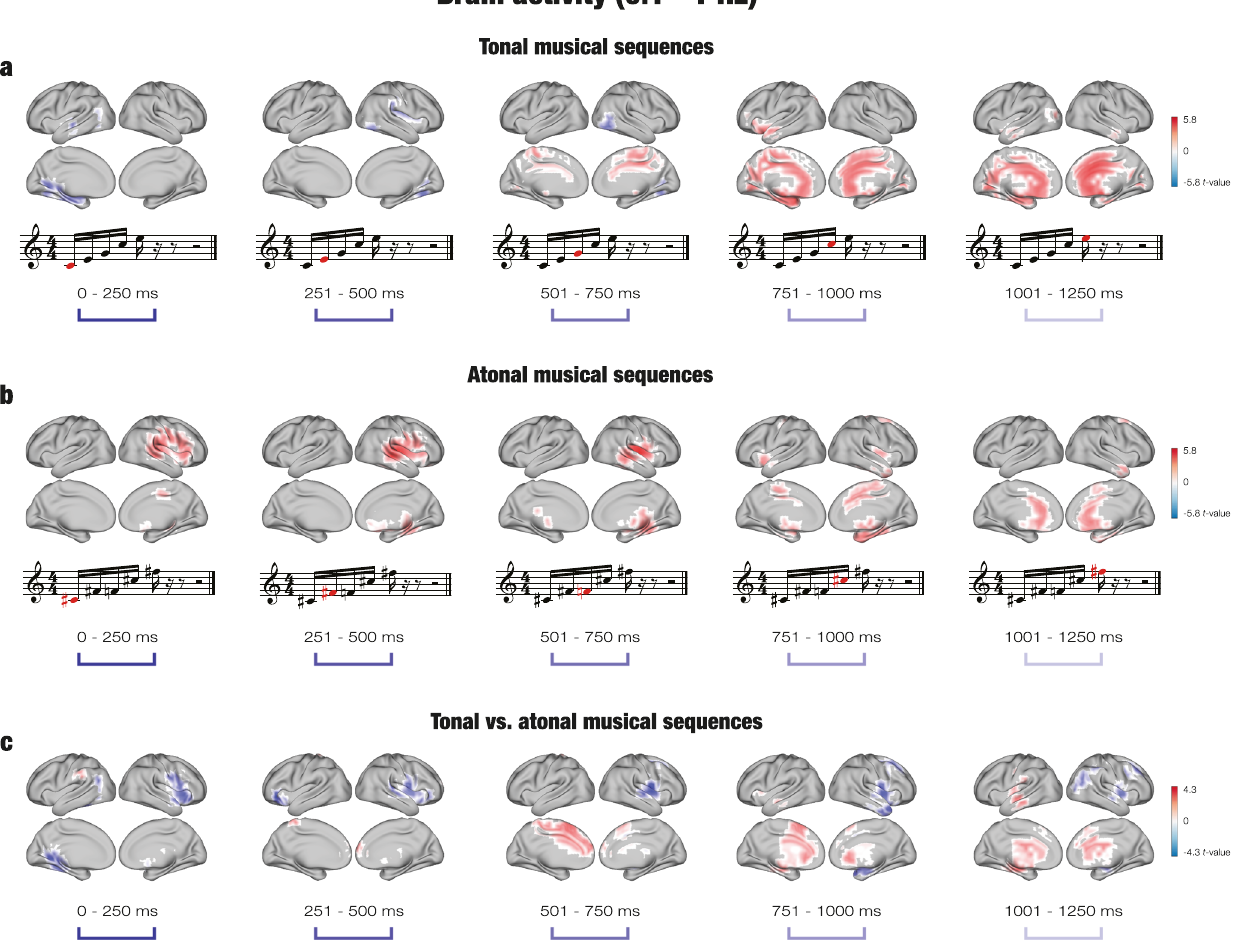
Fig. 3 Brain activity underlying the recognition of musical sequences at the slow frequency band (0.1 – 1 Hz). a For tonal sequences, the brain activity was stronger for memorized (in red) than novel (in blue) sequences, particularly for the third (501 – 750ms), fourth (751 – 1000 ms), and fi fth (1001 – 1250) tones. The difference was localized in memory processing areas such as the cingulate gyrus, hippocampus, and parahippocampal gyrus. The analysis involved n = 71 participants. b For atonal sequences, the brain activity was stronger for memorized than novel sequences for all tones. The difference was mainly localized in auditory processing areas (e.g., superior temporal gyrus, Heschl ’ s gyrus) for the fi rst three tones, and in memory processing areas (e.g., parahippocampal gyrus, hippocampus) for the fourth and fi fth tones. The analysis involved n = 71 participants. c For the contrast between memorized tonal and atonal sequences, the brain activity was localized in memory processing areas for tonal sequences (in red), particularly for the last three tones, and in auditory processing areas for atonal sequences (in blue) for all tones. The analysis involved n = 71